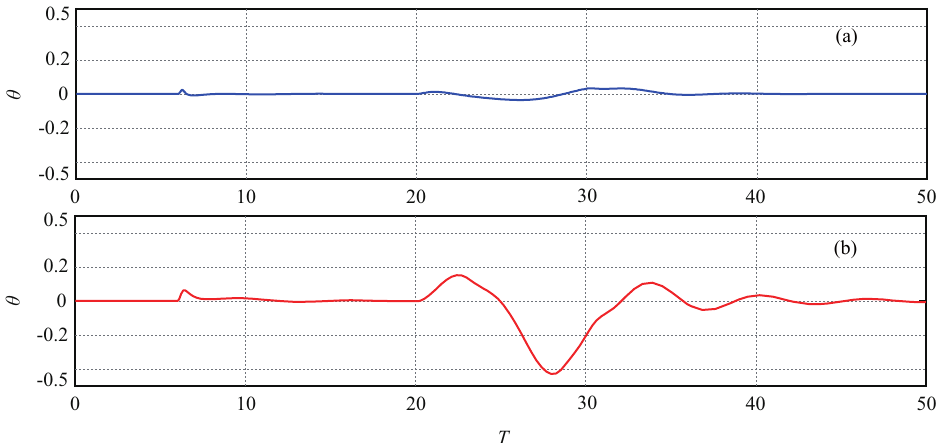
Figure 6. Robustness test results of the dimensionless trolley displacement under different exter- nal disturbances [( a ) Proposed method; ( b ) Method in [35]].